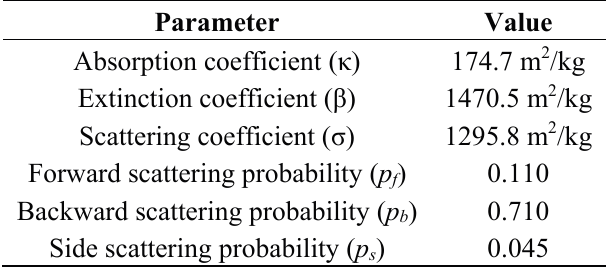
Table 1. Optical parameters of TiO 2 Aeroxide P-25 in water averaged across the solar